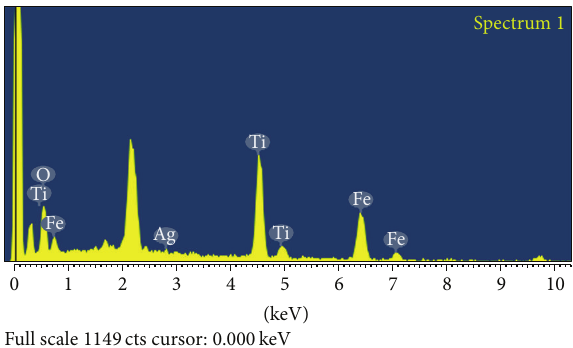
Figure6:EnergydispersiveX-rayspectrafortheas-synthesizedAg- TiO 2 /Fe 3 O 4 . Table 2: Characterization data of EDX for Ag-TiO